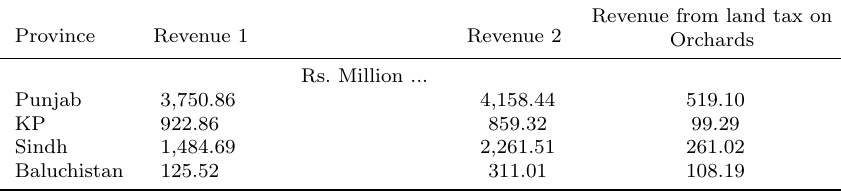
Table 3: Tax revenue estimates as per provincial land-based tax